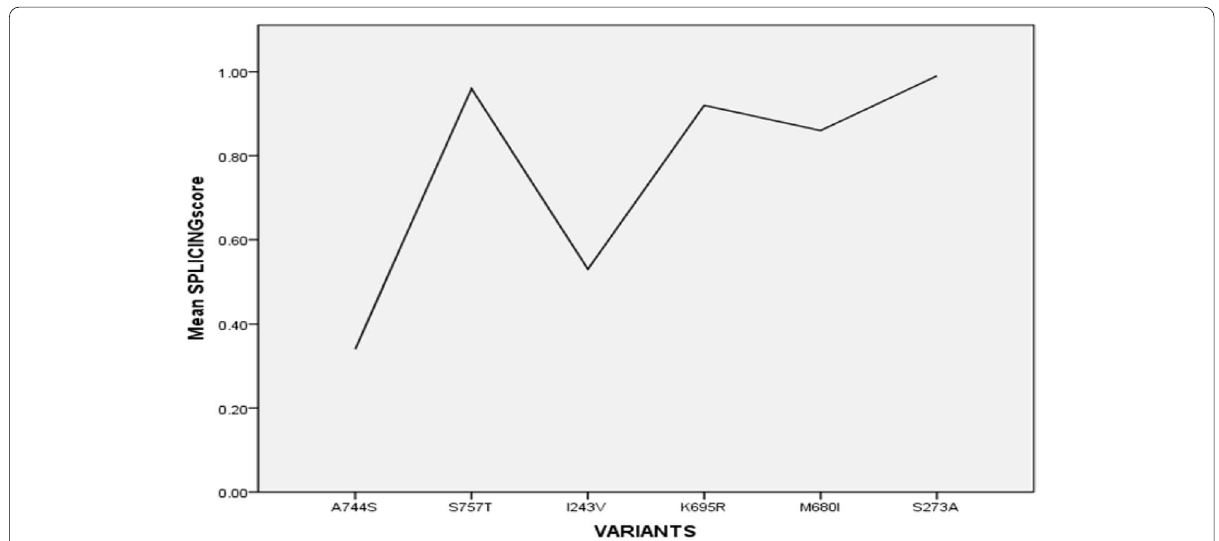
Fig. 6 Predicted alternative splicing score for retrieved variants